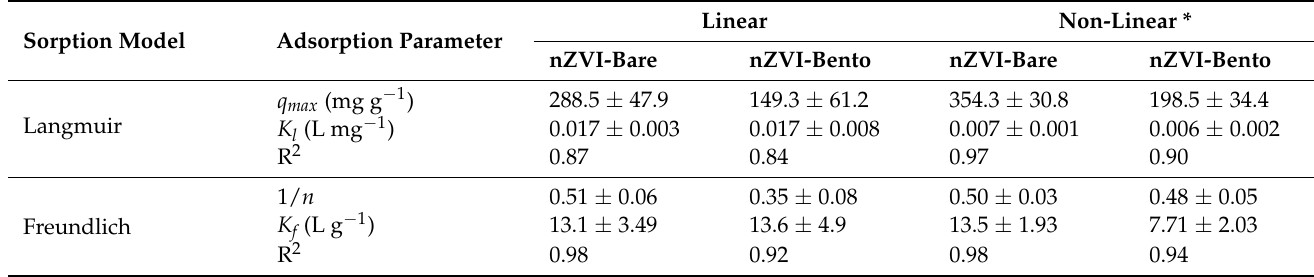
Table 2. Sorption model parameters for As (V) sorption on ZVI products. Sorption